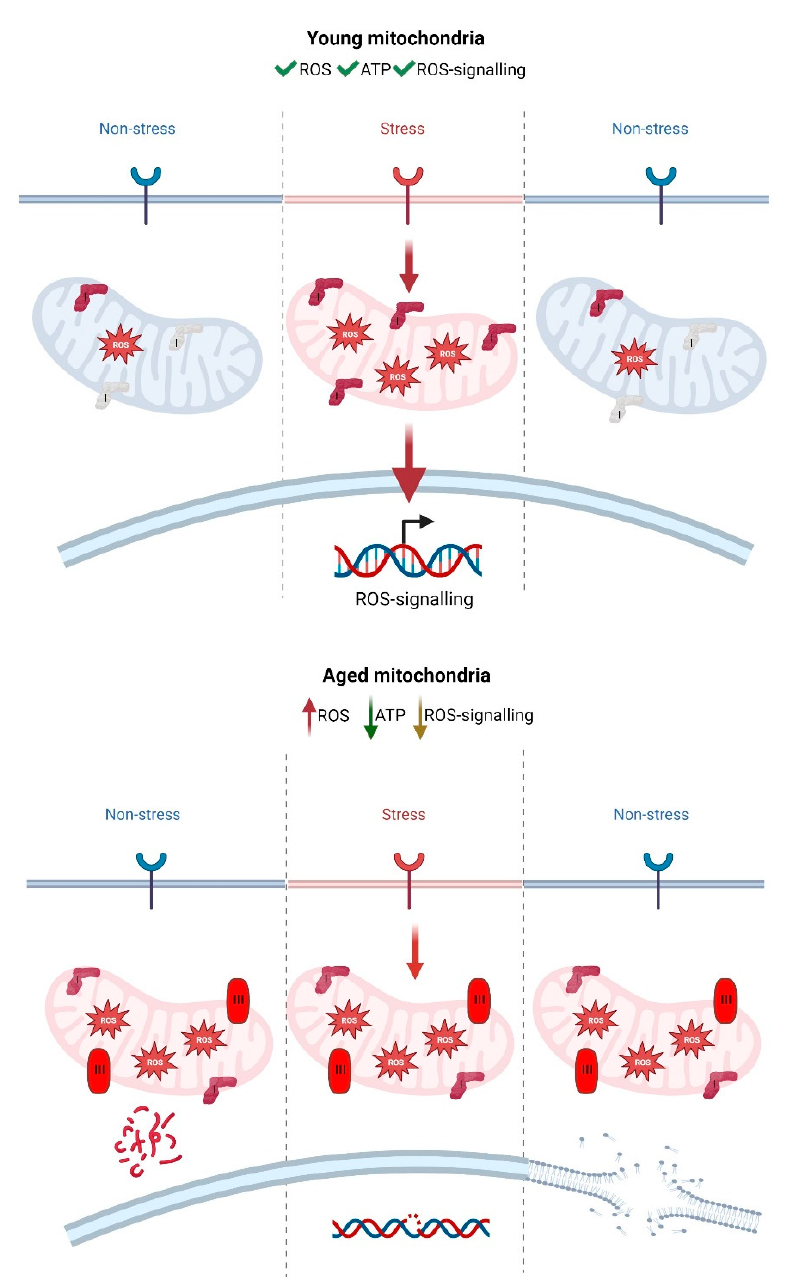
Figure 4. Mitochondrial redox signalling is altered during ageing, with young mitochondria producing ROS only in response to specific stimuli, thereby maintaining low total ROS levels. Conversely, ageing mitochondria continually produce high levels of ROS and are unresponsive to external stimuli, resulting in oxidative stress and damage. Antioxidants alone are not effective in increasing lifespan, as, while they can reduce oxidative damage, they cannot restore redox signalling. Effective antiageing therapies require not only a reduction in oxidative damage but also restoration of mitochondrial ROS (mtROS) signalling. The figure illustrates the contrasting differences between young and ageing mitochondria, highlighting the importance of restoring mtROS signalling for healthy ageing. For the sake of clarity, we only depicted CI-generated ROS in young mitochondria. Nevertheless, it is evident that CIII also plays a significant role in generating ROS in young and healthy individuals. In aged mitochondria, both CI and CIII are displayed to indicate the likelihood that multiple ROS generators (both specific and non-specific) are concurrently